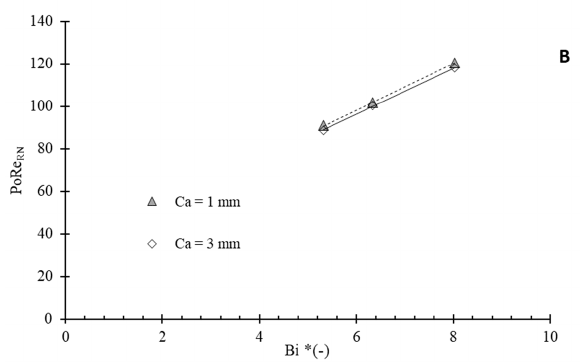
Figure 9. Re RN versus Bi* curves, ( A )—CFD, ( B )—Experiment.